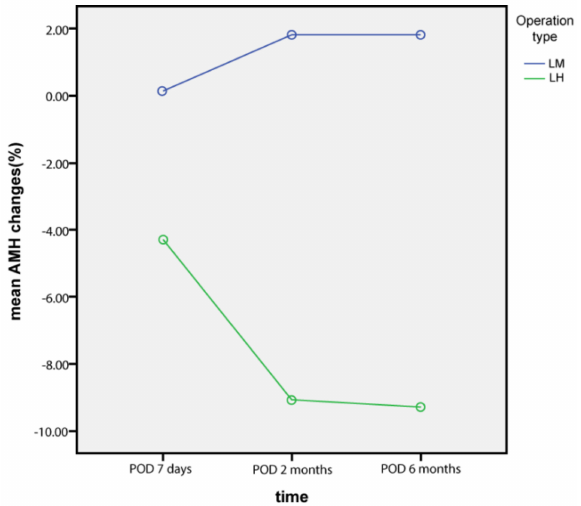
Figure 2. AMH changes from baseline levels (%).